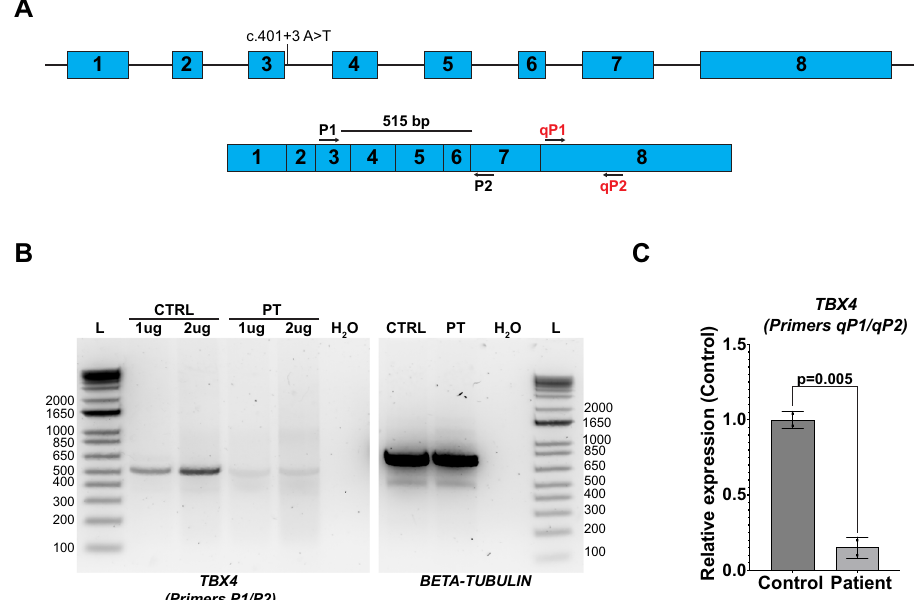
Fig. 2 Reduced TBX4 expression in proband-derived lymphoblastoid cell lines. A Schematic of TBX4 genomic structure (top) and spliced cDNA (bottom). Primer pairs used in B and C are depicted. B PCR analysis of TBX4 transcript using primers P1 and P2 on cDNA derived from 1ug or 2ug of RNA isolated from control (CTRL) or proband-derived (PT) lymphoblastoid cell lines (left panel). PCR analysis of β -tubulin transcript was used as a control (right panel). H 2 O denotes water control and L denotes the 1 Kb ladder. C qPCR analysis of TBX4 expression using primers qP1 and qP2 on control and proband-derived lymphoblastoid cell lines. Data is normalized to GAPDH expression and is expressed relative to control sample expression. Two biologic replicates included per experiment that were repeated N = 2. P -value determined by Student ’ s 2-tailed t -test. Error bars re fl ect standard